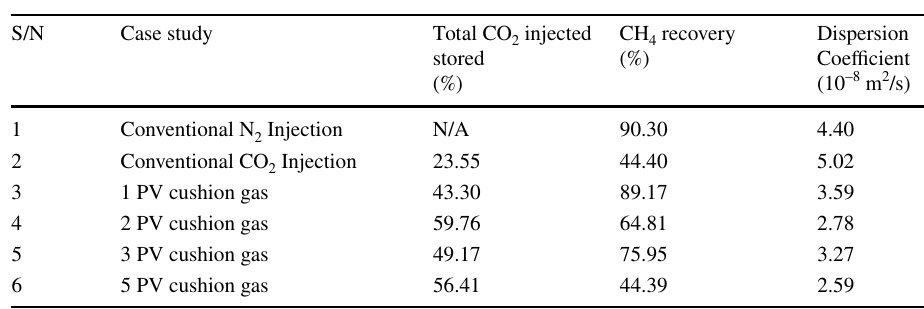
Fig. 15 Differential pres- sure (dP) changes during the experimental runs with cushion gas compared to conventional